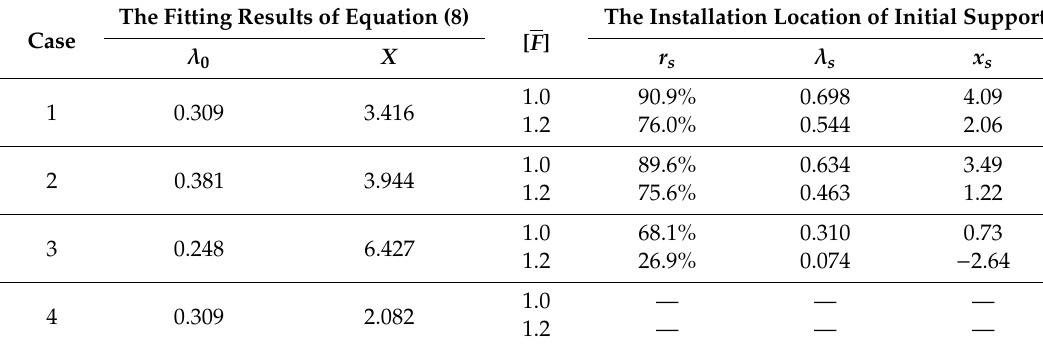
Table 2. Results of the support installation.